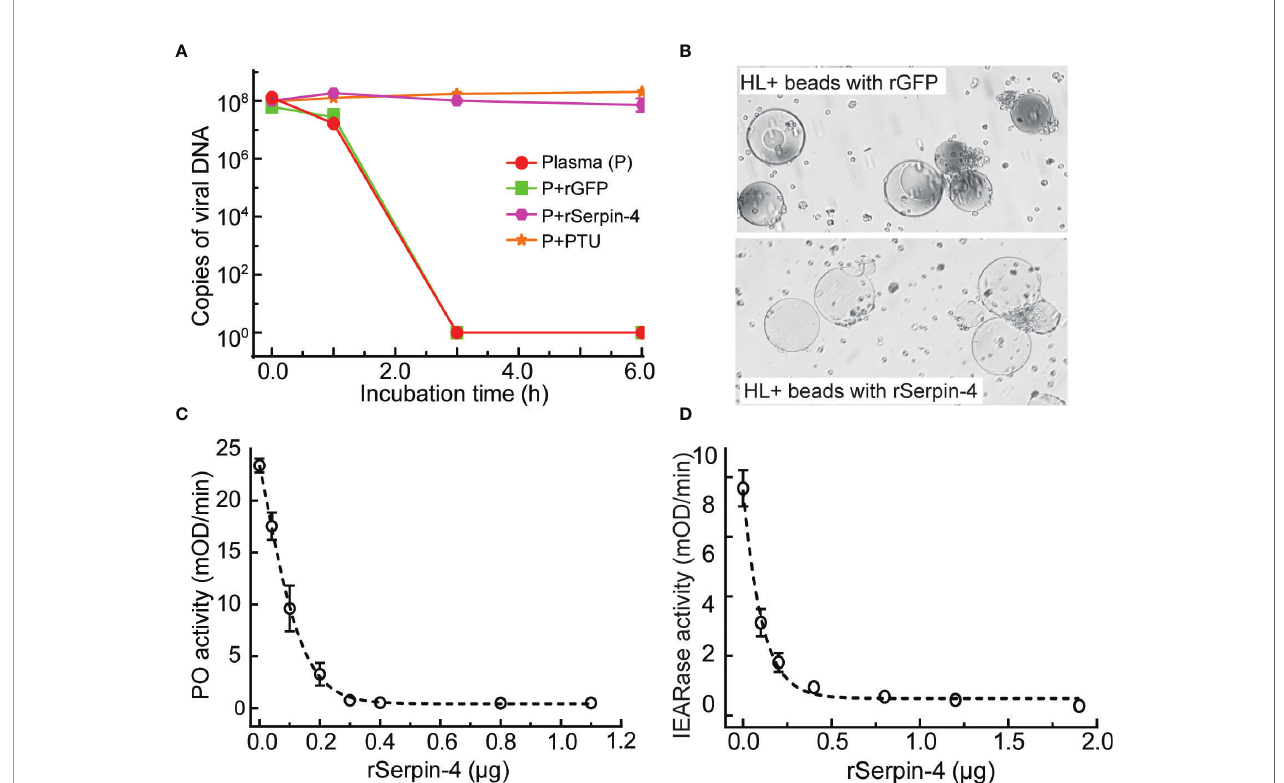
FIGURE 4 | Inhibition analysis of melanization by O. furnacalis serpin – 4. (A) Determination of gDNA copy numbers of AcMNPV in plasma incubated with inhibitors. AcMNPV was mixed with plasma, plasma plus PTU (P+PTU), plasma plus recombinant GFP (P+rGFP) or plasma plus recombinant serpin – 4 (P+rSerpin – 4). The mixtures were incubated at room temperature for 0, 1, 3, or 6 h, and the numbers of gDNA copies were determined by qRT – PCR. The data points represented the mean ± S.D. ( n = 3). (B) Serpin – 4 suppressed the melanization of Ni – NTA agarose beads. Ni – NTA agarose beads coated with recombinant GFP or serpin – 4 were incubated with hemolymph from O. furnacalis larvae. The melanized beads were observed and photographed under a microscopy after 2 h of incubation. (C) Inhibition of PO activation by serpin – 4. Hemolymph (1 m L) collected from fi fth instar larvae was incubated for 10 min at room temperature with puri fi ed recombinant serpin – 4 at different concentrations. PO activity was monitored using dopamine as substrate. The bars represented the mean ± S.D. ( n = 3). (D) Inhibition of IEARase activation by serpin – 4. Hemolymph (1 m L) collected from fi fth-instar larvae was incubated with puri fi ed recombinant serpin – 4 at different concentrations. The residual IEARase activity of hemolymph was plotted as the mean ± S.D. ( n =